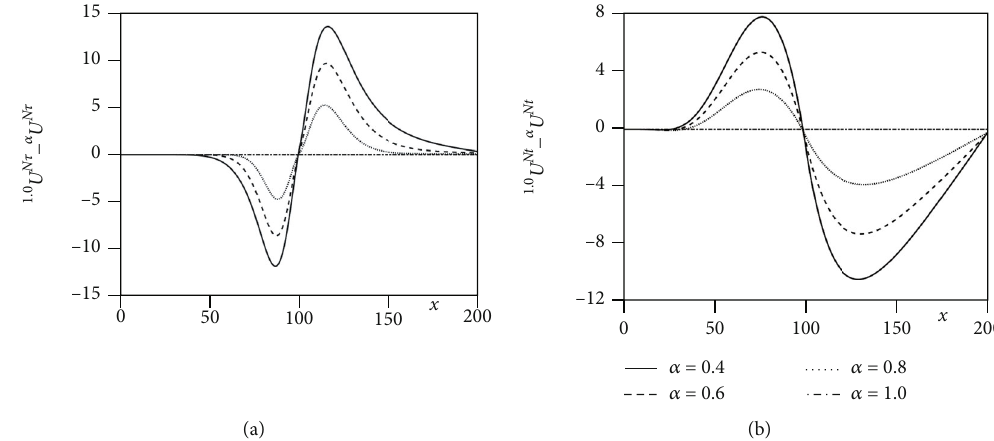
Figure 4: Di ff erences in the numerical solutions between α = 1 : 0 and α = 0 : 4,0 : 6,0 : 8 , and 1.0 for maturity times (a) T = 0 : 1 and (b) T = 2 : 5 .